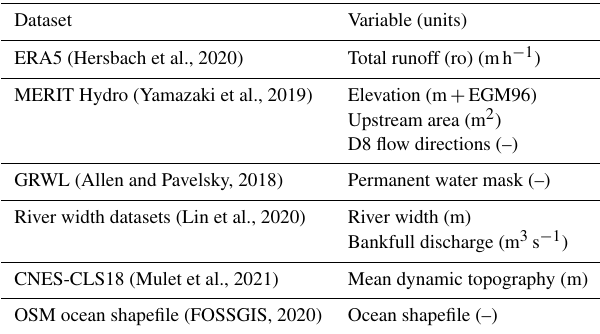
Table 1. Overview of global datasets used to set up the hydrody- namic flood